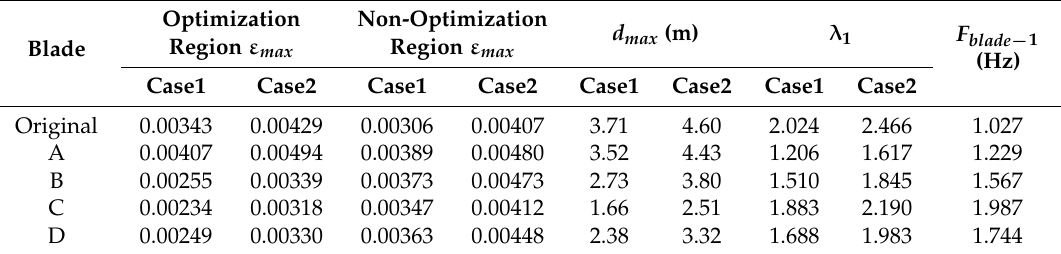
Table 6. Comparison of the structural behaviors under different load